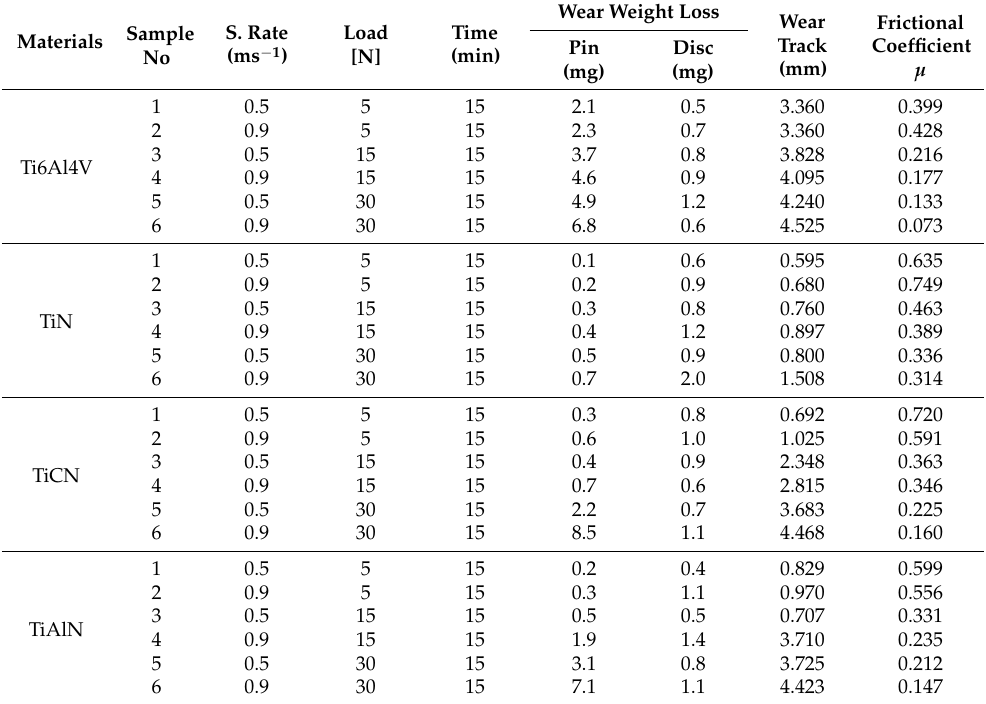
Table 4. Weight loss, wear track widths, friction coefficient values for uncoated Ti alloy and coatings at different loads and sliding